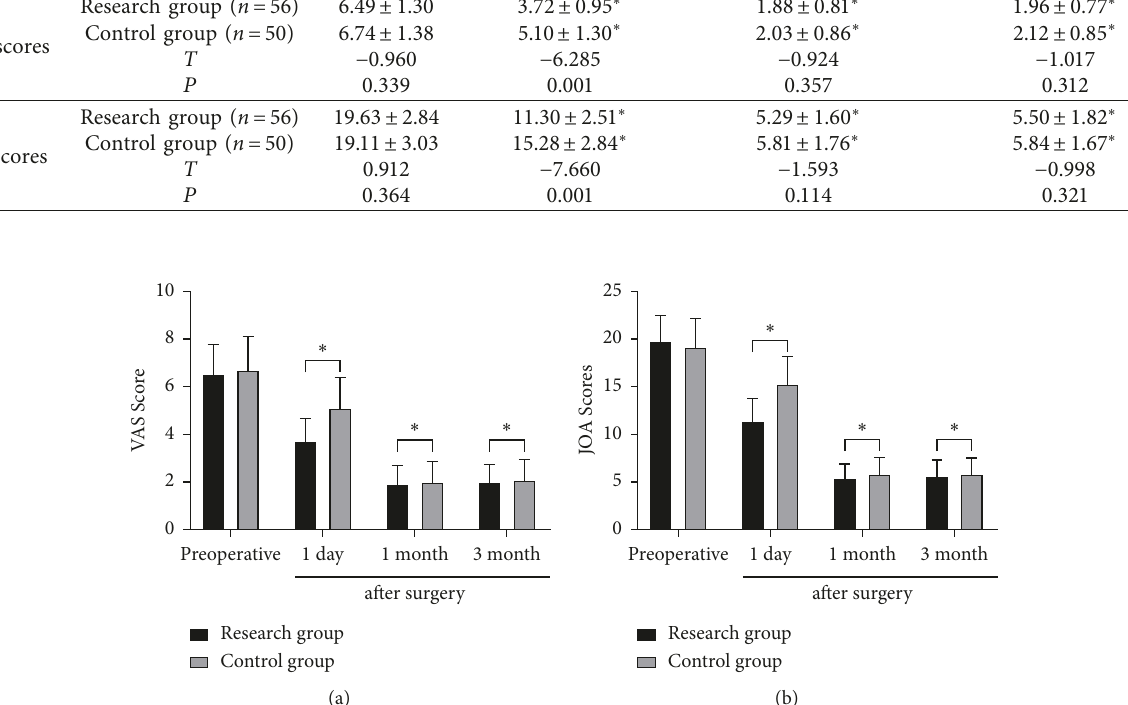
Table 4 for details. Table 4 Comparison of bone graft fusion rate between the two groups ( n (%)).